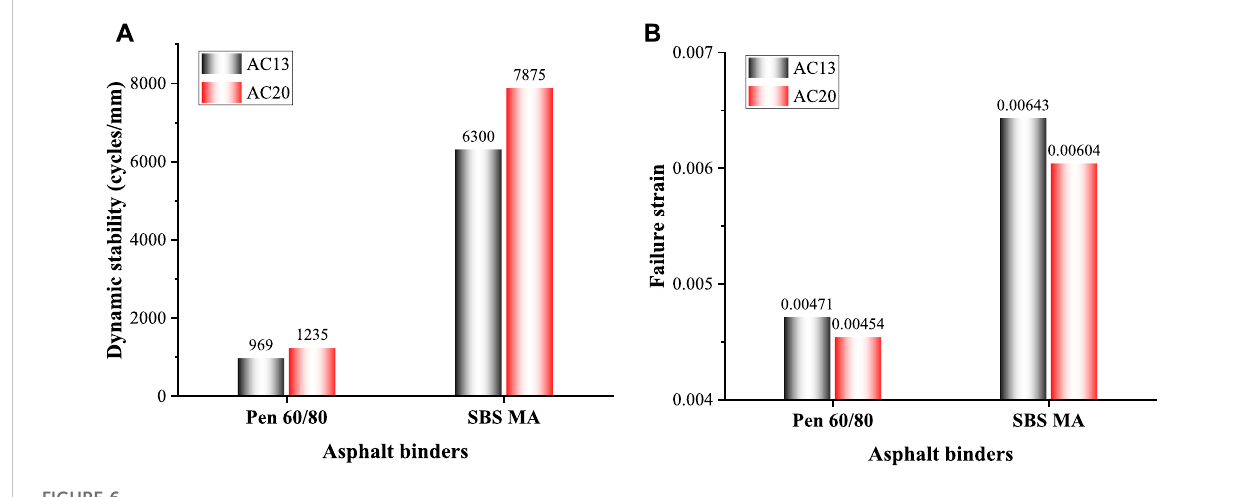
FIGURE 6 Rutting and cracking resistance of mixtures with different asphalt binders: (A) dynamic stability and (B) failure